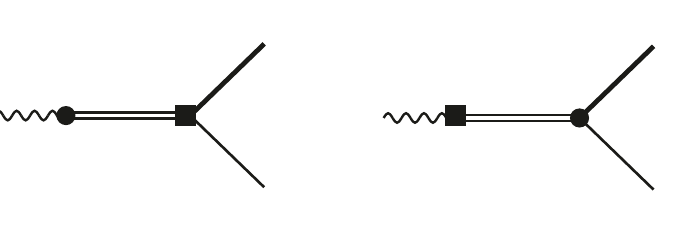
Figure 10 . The diagrams for the exchange of zero-width resonances (double line). The external lines correspond to the insertion of the current j (cid:22) ( x ) (wiggly line) and to the kaon (thick line) and pion (thin line). The circular blob denotes a strong coupling vertex, and the square box a weak coupling vertex. The diagram on the left corresponds to the exchange of resonances with J PC = 1 (cid:0)(cid:0) , I = 1, S = 0, like the (cid:26) or the (cid:30) (1020) meson. The resonances exchanged in the diagram on the right have quantum numbers J P = 1 (cid:0) , I = 1 = 2, S = 1, like the K (cid:3) (892). (cid:6) where the function A ( D ) is only constrained by the condition A (4) = A , A ( D ) = A + ( D (cid:0) 4) A 0 + , and A 0 parameterizes the scheme-dependence arising from the Dirac (cid:1) (cid:1) (cid:1)